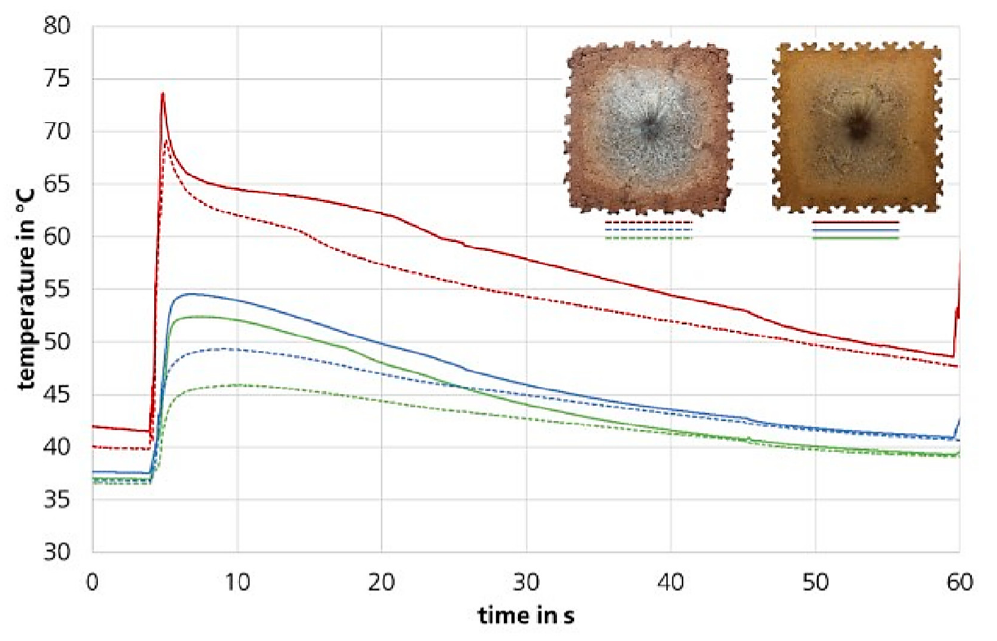
Figure 5. Temperature distribution in dependence on the time for two injection molding processes. Dotted line is the not perfectly fabricated